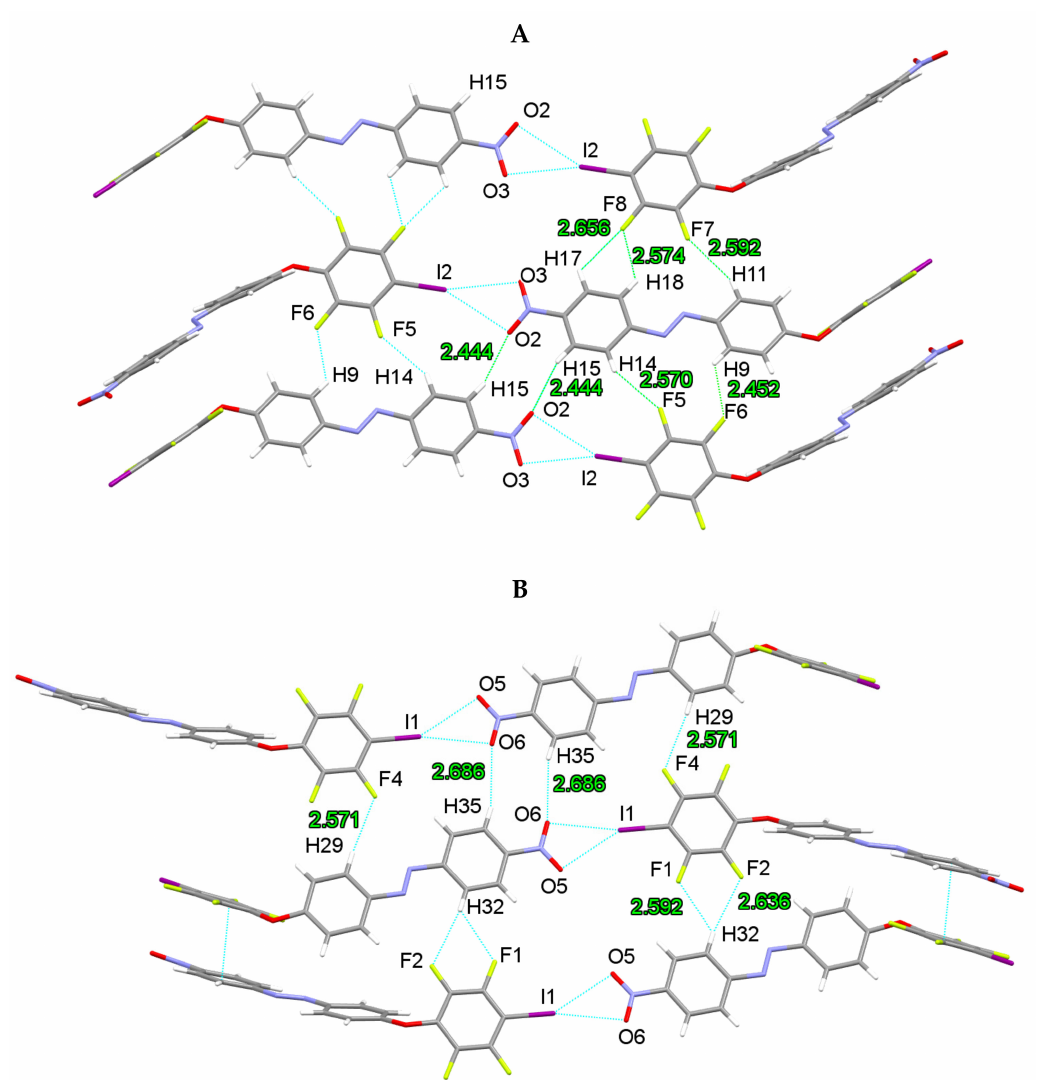
Figure 2. X-ray structure of I–azo–NO 2 highlighting the H15 ··· O2 ··· I2 ( A ) and H35 ··· O6 ··· I1 ( B ) orthogonal hydrogen and halogen